Question: From the figure, is the trend upward or downward?
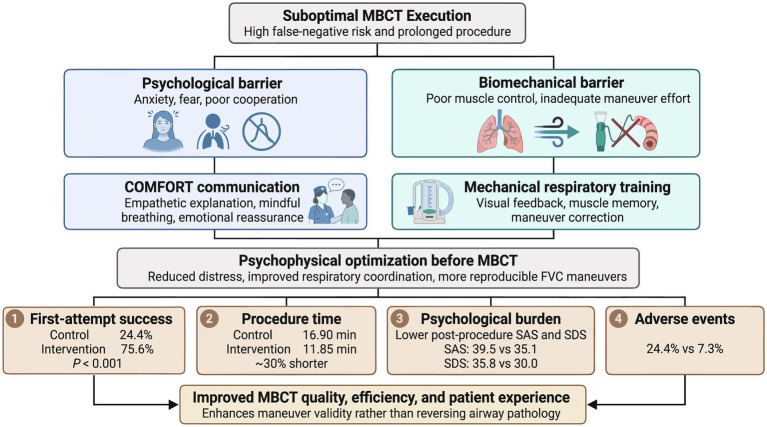
Answer: increasing